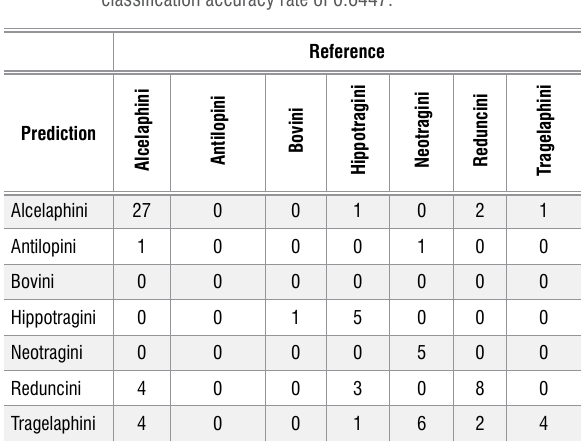
Table 3: Confusion matrix of the worn teeth. These teeth had a correct classification accuracy rate of 0.6447.